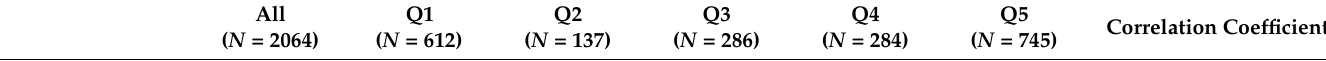
Table 4. Green space features according to neighbourhood socioeconomic deprivation quintiles